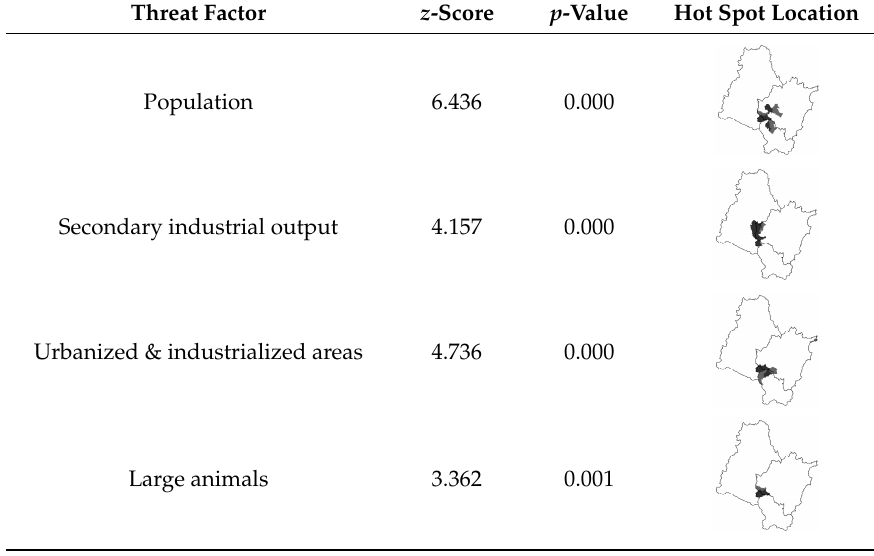
Figure 2. Spatial distribution of frequency for the 10 individual factors, with low, moderate, high, and very high values sorted by quartile in ascending order. Table 2. Getis-Ord General G statistic results of frequency for the factors and their hot spot locations.